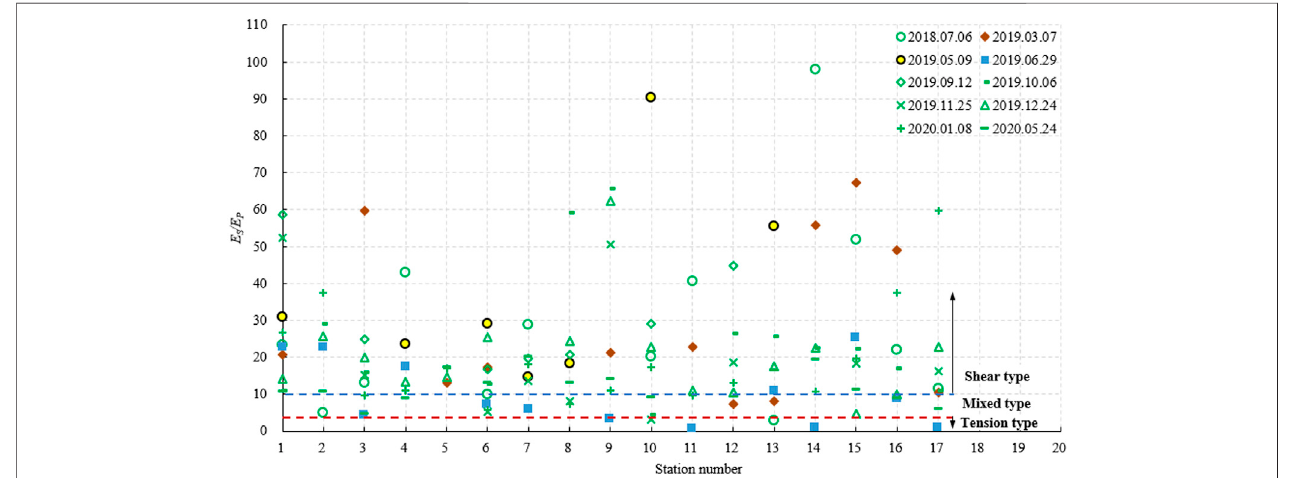
FIGURE 11 | Es/Ep in each channel of previous burst